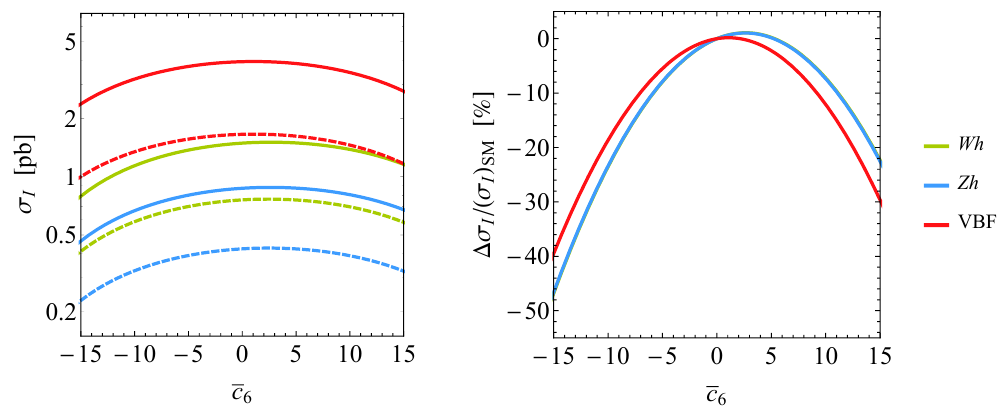
Figure 4 . Left: predictions for the inclusive Wh , Zh and VBF Higgs production sections (cid:27) I as a function of (cid:22) c 6 . The dashed and solid curves correspond to respectively. Right: relative modi(cid:12)cations of (cid:27) I as a function of the Wilson coe(cid:14)cient of O 6 . Only p results for s = 13 TeV are